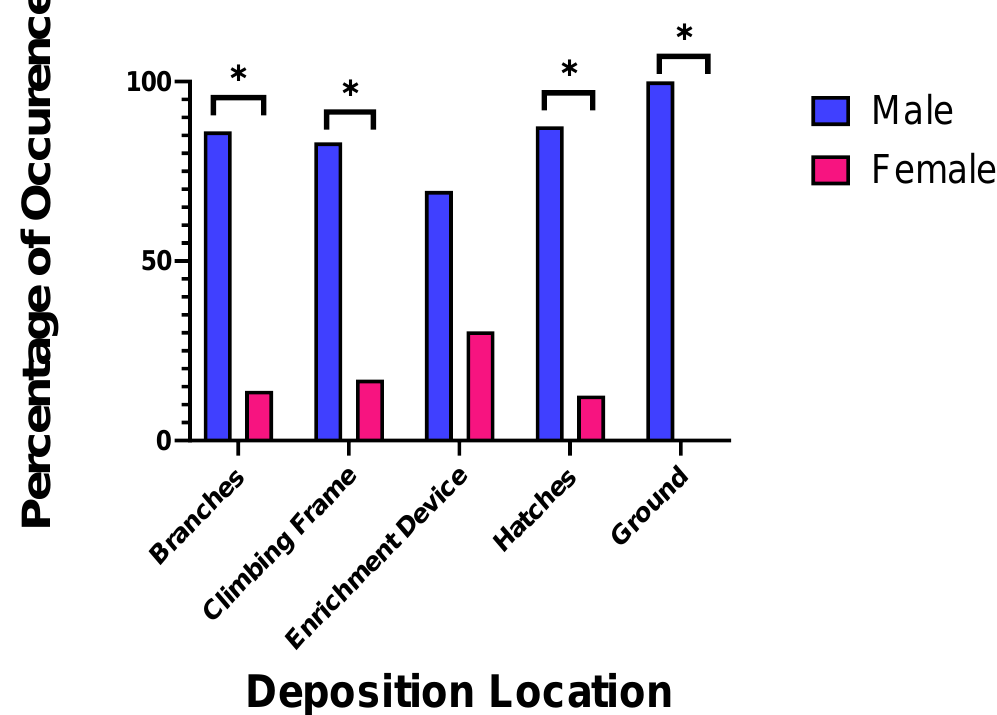
Figure 2. The percentage of total ano-genital scent-marks deposited on each location associated with sex. A * indicates where significant differences between the sexes were found.